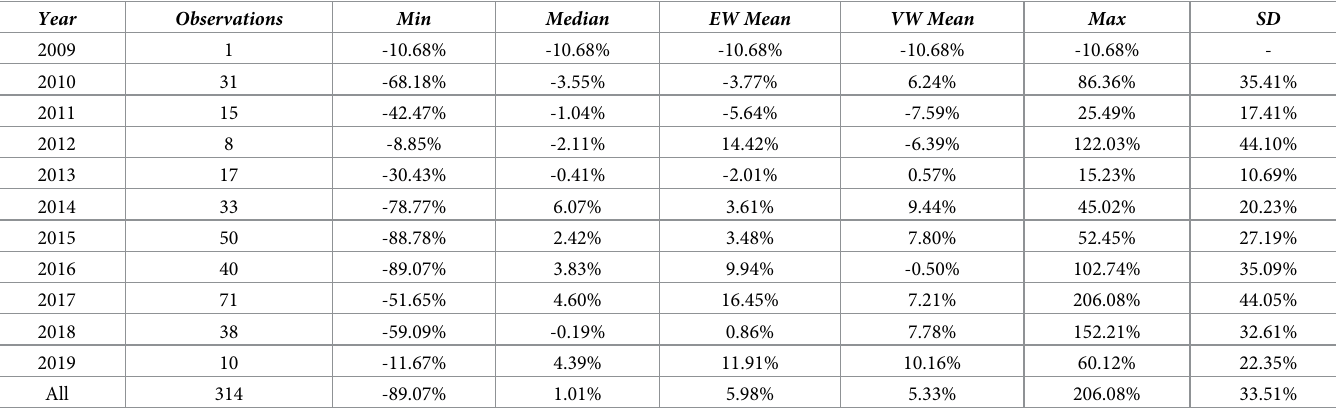
Table 2. Descriptive statistics of first-week returns on the issuing firms’